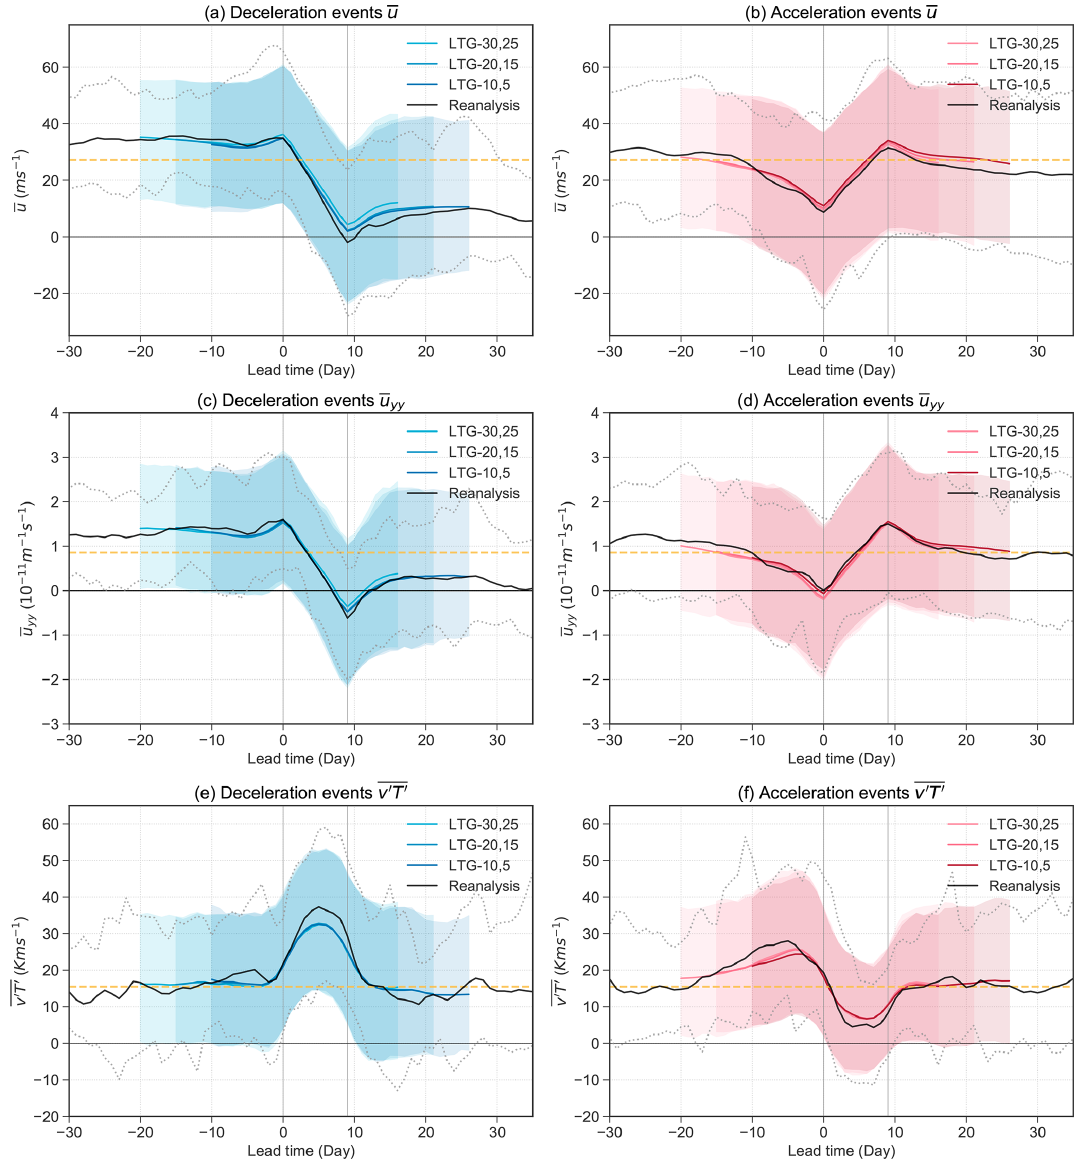
Figure 7. Temporal evolution of u , u yy and v (cid:48) T (cid:48) for (a, c, e) the strong deceleration and (b, d, f) the strong acceleration events identified in the model at different LTGs. Solid lines indicate the mean of the event composites, and shadings indicate the 5th and 95th percentiles of the events in the prediction system. Solid black lines and dotted black lines indicate the mean and the 5th and 95th percentiles for the reanalysis, respectively. Dotted yellow lines show the winter climatology in reanalysis. The first and last 5d in the mean evolution in the model composite are discarded to account for the different start dates within each